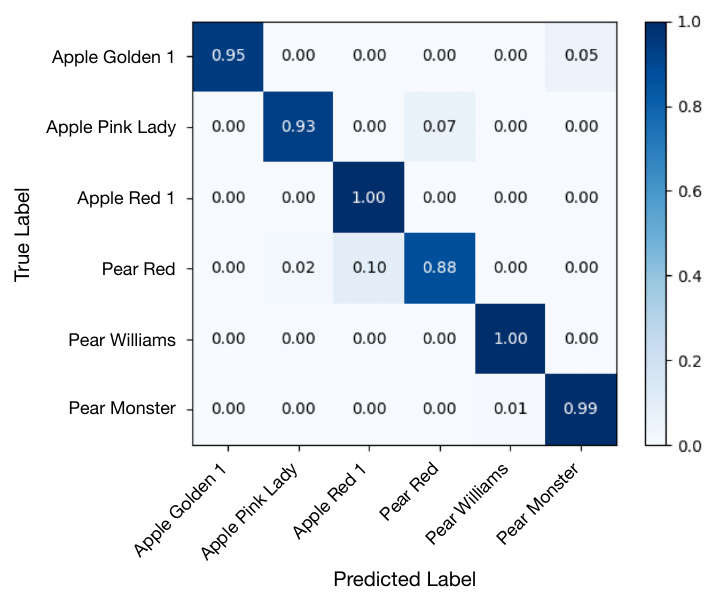
Figure 13. Confusion matrix for fruit classification results on Fruit-360 dataset [70].